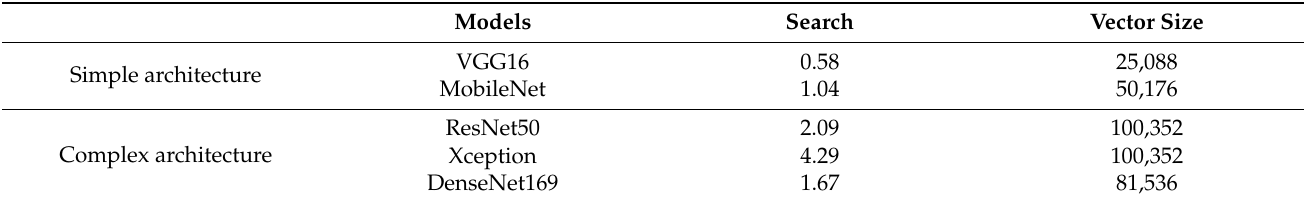
Table 2. Comparison of models based on time search (in seconds) and vector